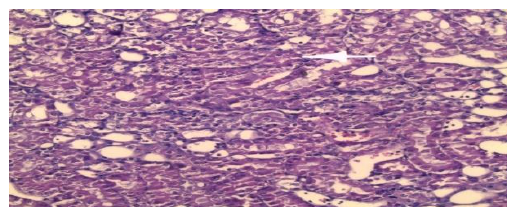
Figure (1): Cisplatin-induced AKI day3. rat n: 7(Necrosis)